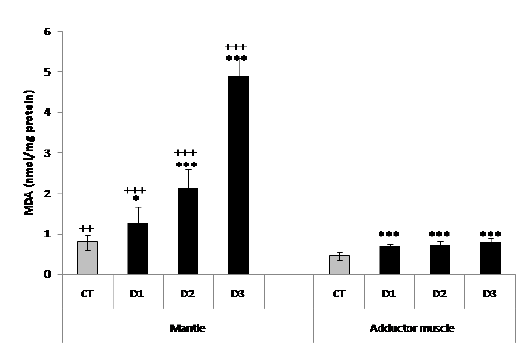
Figure 2. The MDA levels in the control and treated M. stultorum mantle and adductor muscles with Pb Cl 2 graded doses (D1, D2, D3) during 5 days. Values are expressed as means ± SD, 6 replicate in each group and tissues (n = 3 clams). Pb Cl 2 graded doses: D1 (1mg / L Pb Cl 2 ); D2 (2.5mg / L Pb Cl 2 ); D3 (5mg / L Pb Cl 2 ). *** P < 0.001: Pb Cl 2 groups VS controls for each tissue. ++ < 0.01; +++ P < 0.001: mantle VS adductor muscles for each condition.